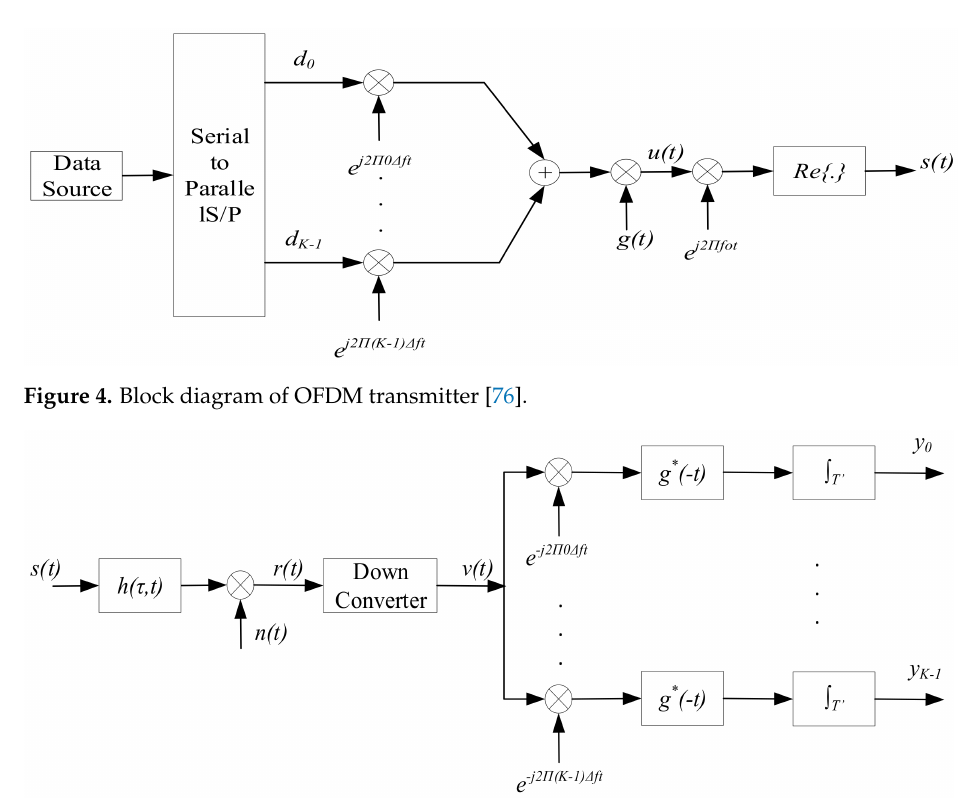
Figure 5. Block diagram of OFDM receiver